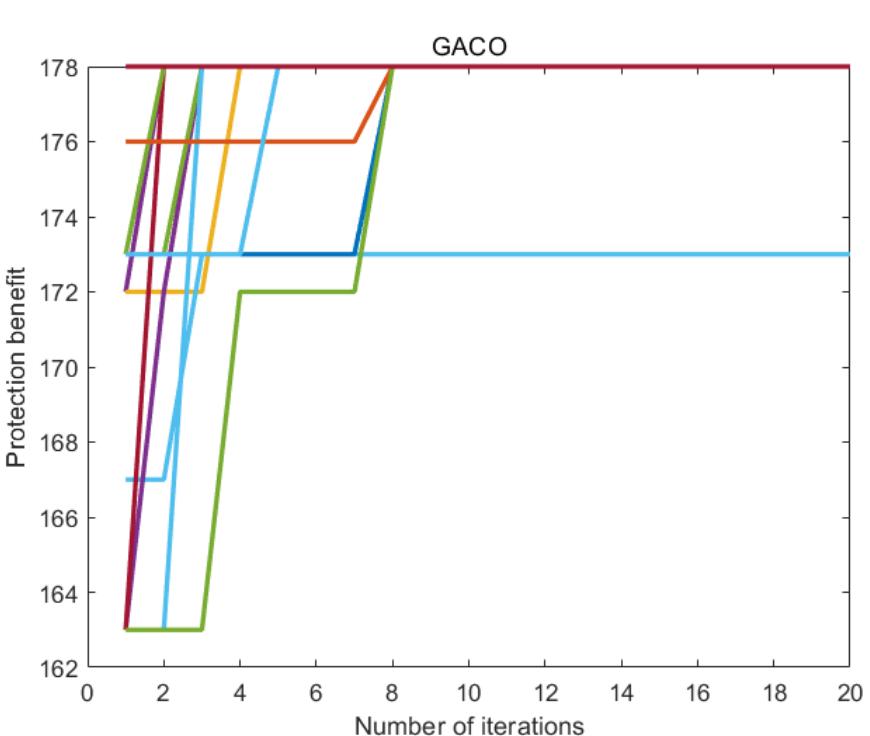
Figure 9. Population size is 15, and the GACO algorithm is run 100 times.